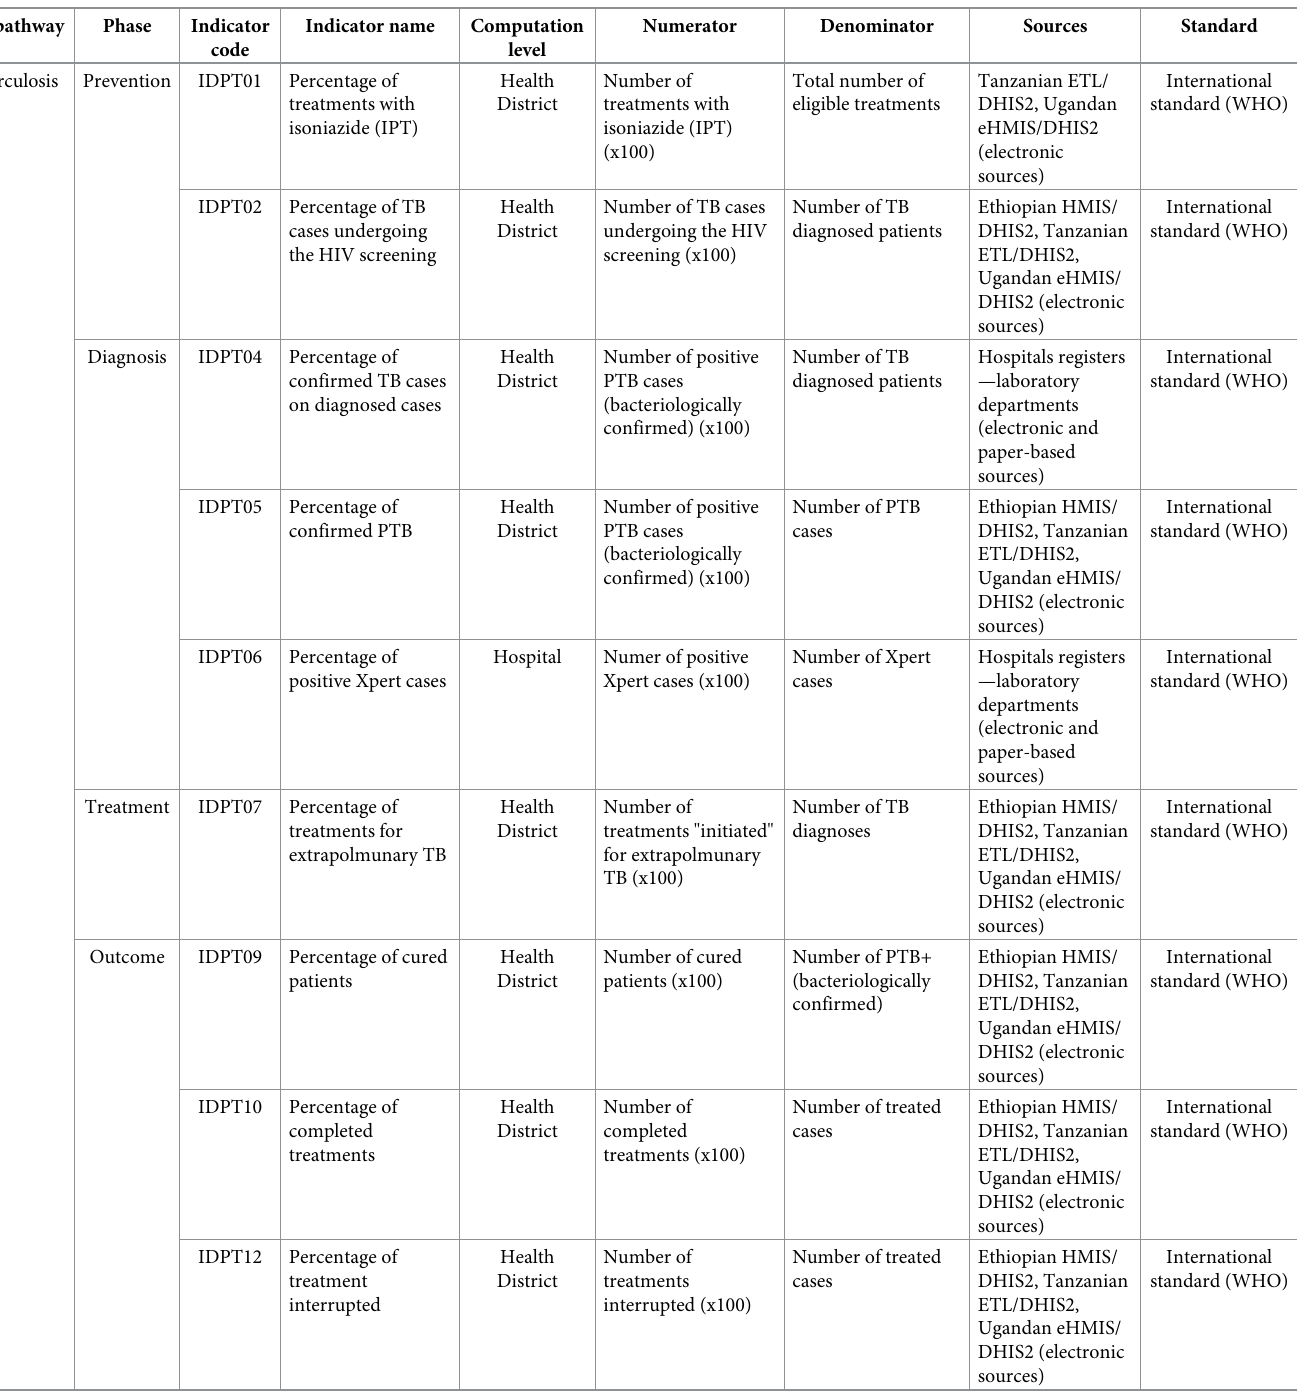
Table 2. Care pathways’